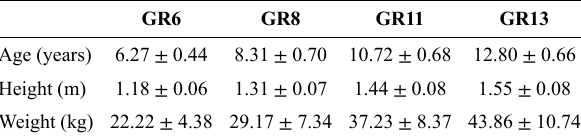
Table 1 - Mean and standard deviation of each group's age, height, and